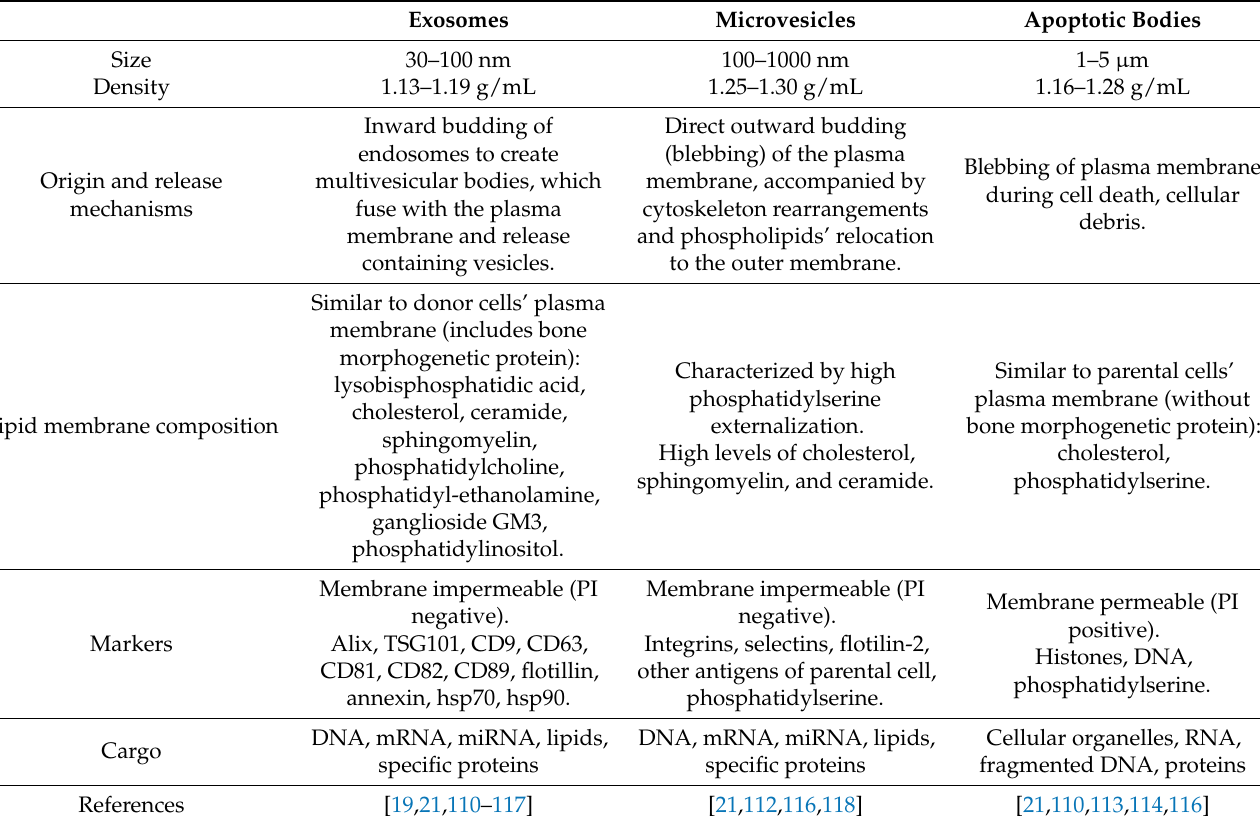
Table 2. Main characteristics of